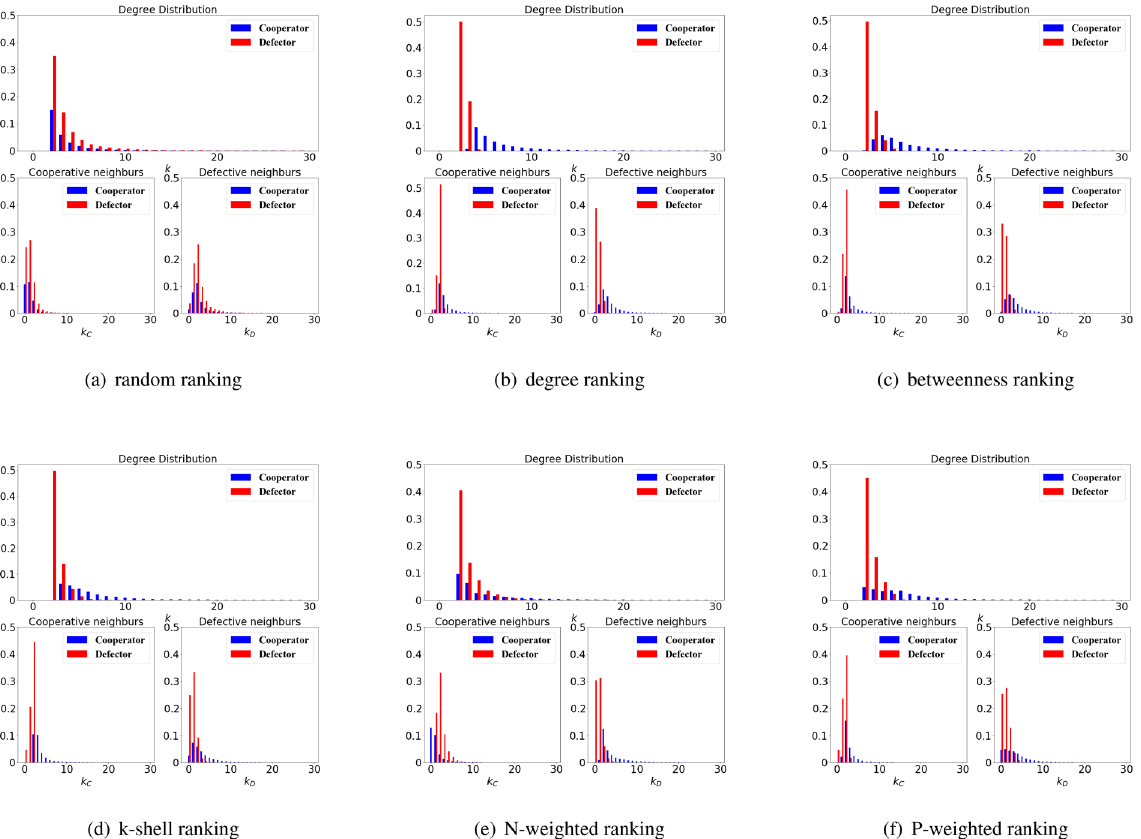
Figure 3. Initial degree and neighbours distributions for cooperators and defectors. The network is scale-free, with ρ = 30% and the cooperators are chosen according to the ranking strategies based on random, degree, betweenness, k-shell, N-weighted degree and P-weighted